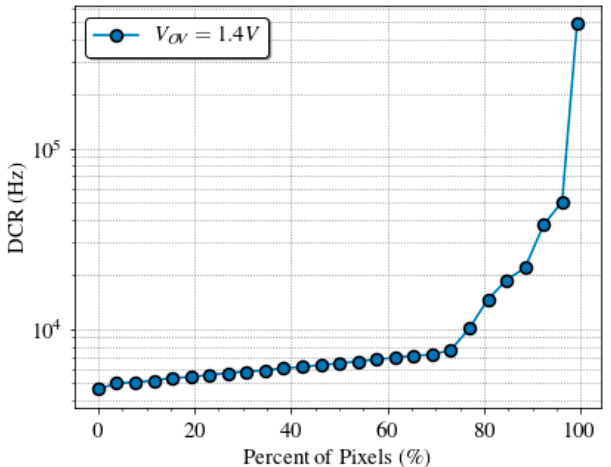
Figure 9. Dark count rate distribution measured across the SPAD array of 13 chips at 1.4 V of overvoltage and room temperature with a maximum relative error of 0.5%.